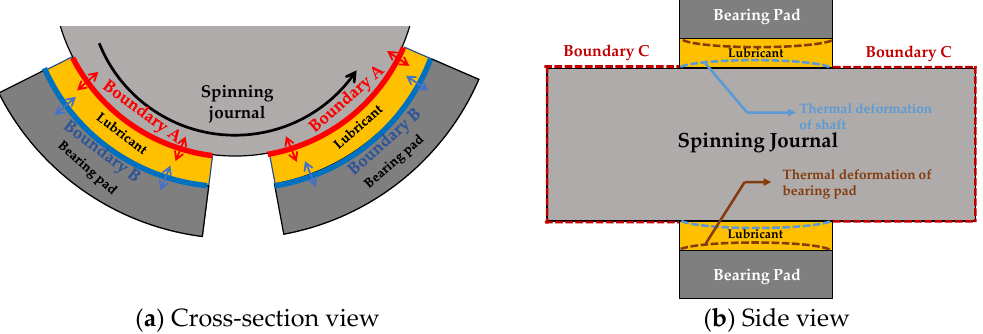
Figure 1. Heat flux boundary conditions and deformation in bearing–journal system.